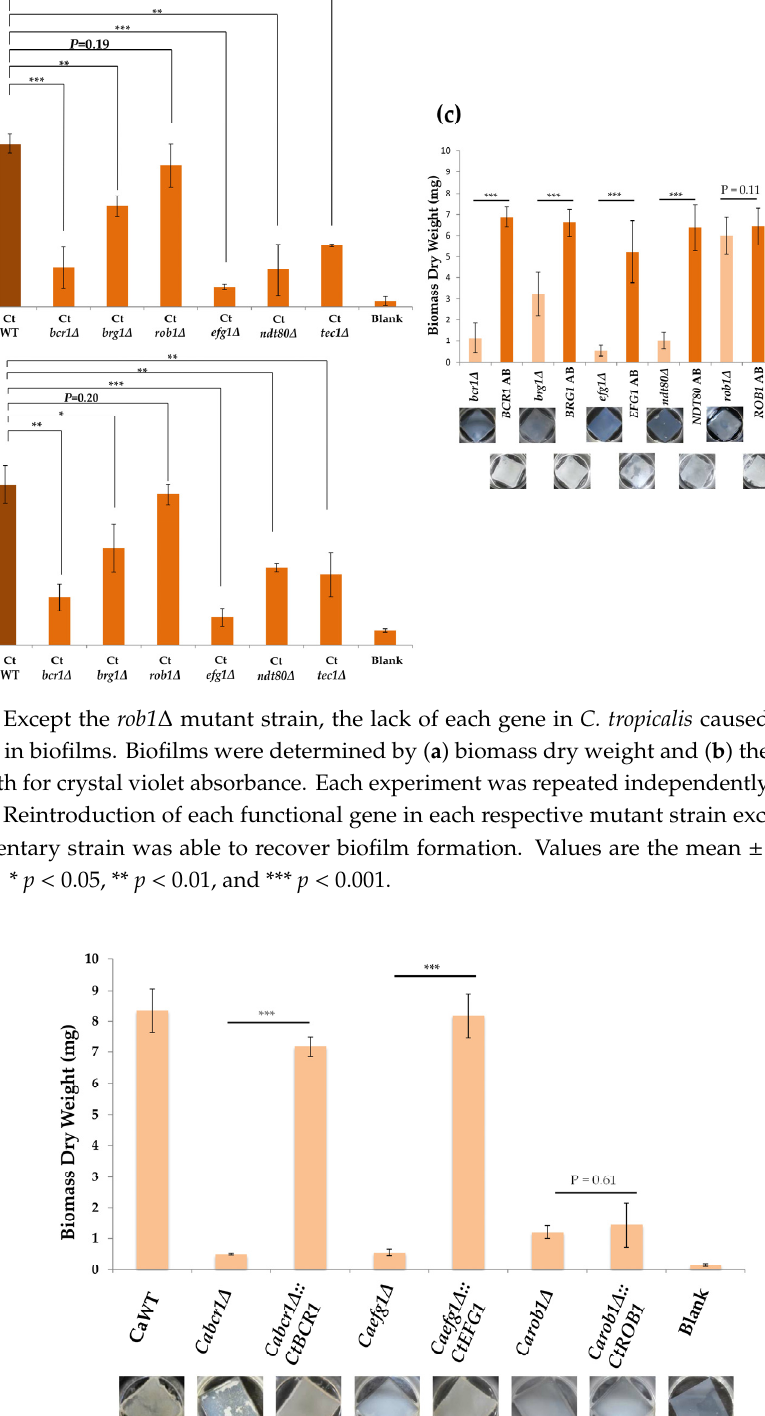
Table 2. Sequence alignment of C. tropicalis Bcr1, Brg1, Efg1, Tec1, Rob1, and Ndt80 with the respective homolog in C. albicans .